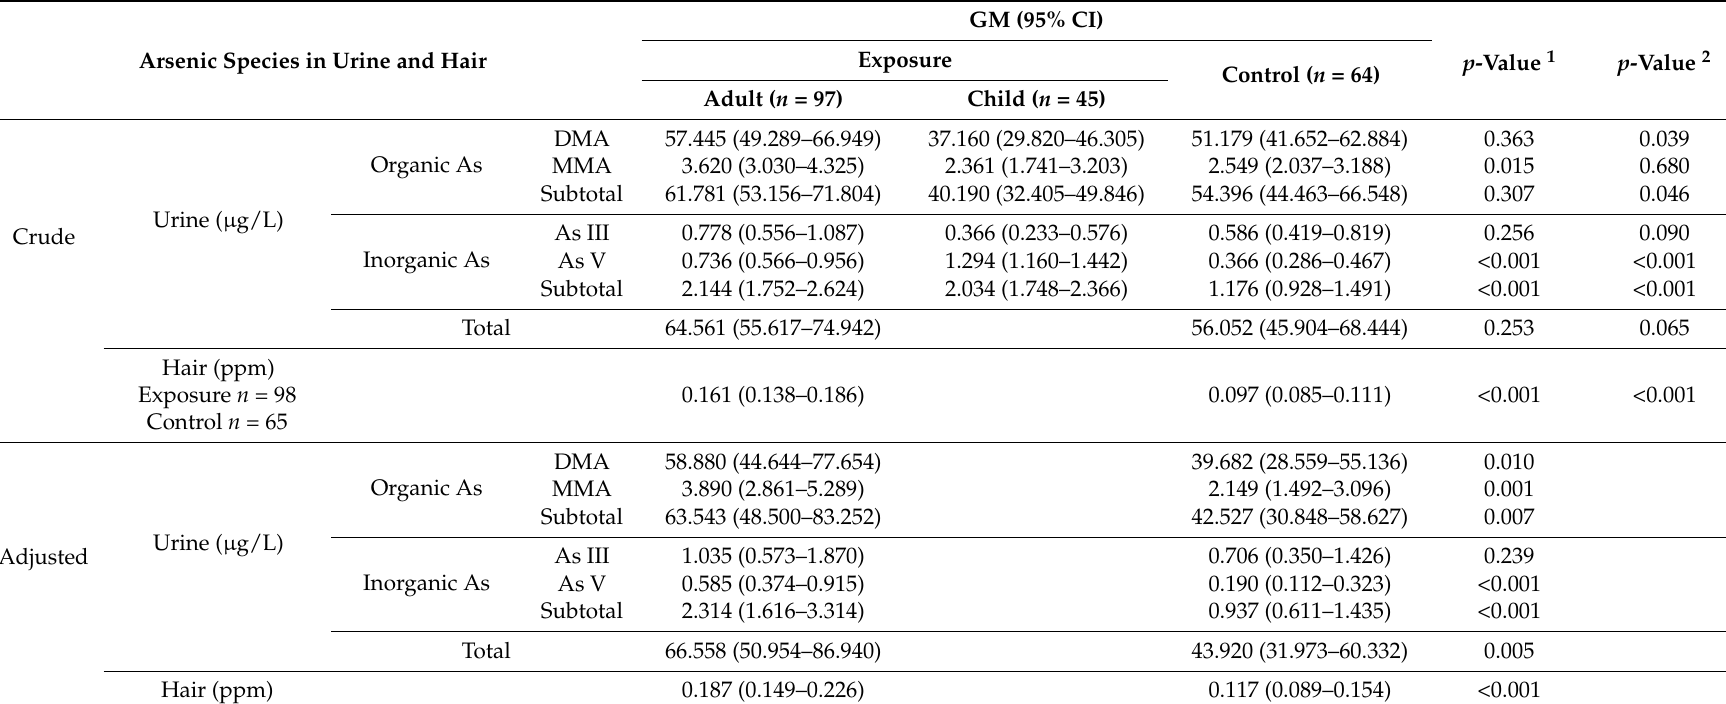
Table 2. Comparison of arsenic